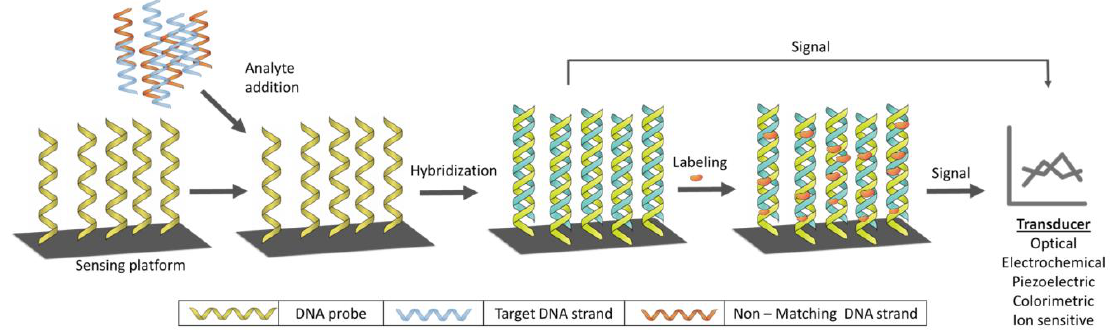
Figure 2. General design and working principle of DNA biosensor.